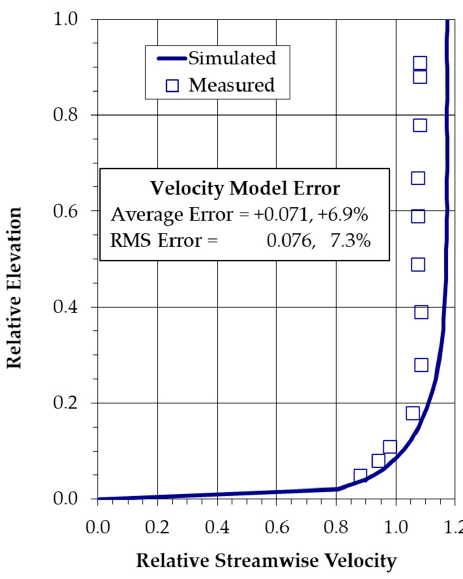
Figure 9. Comparison of simulated and measured velocity profile at cross-section S0 at position − 0.461 B.